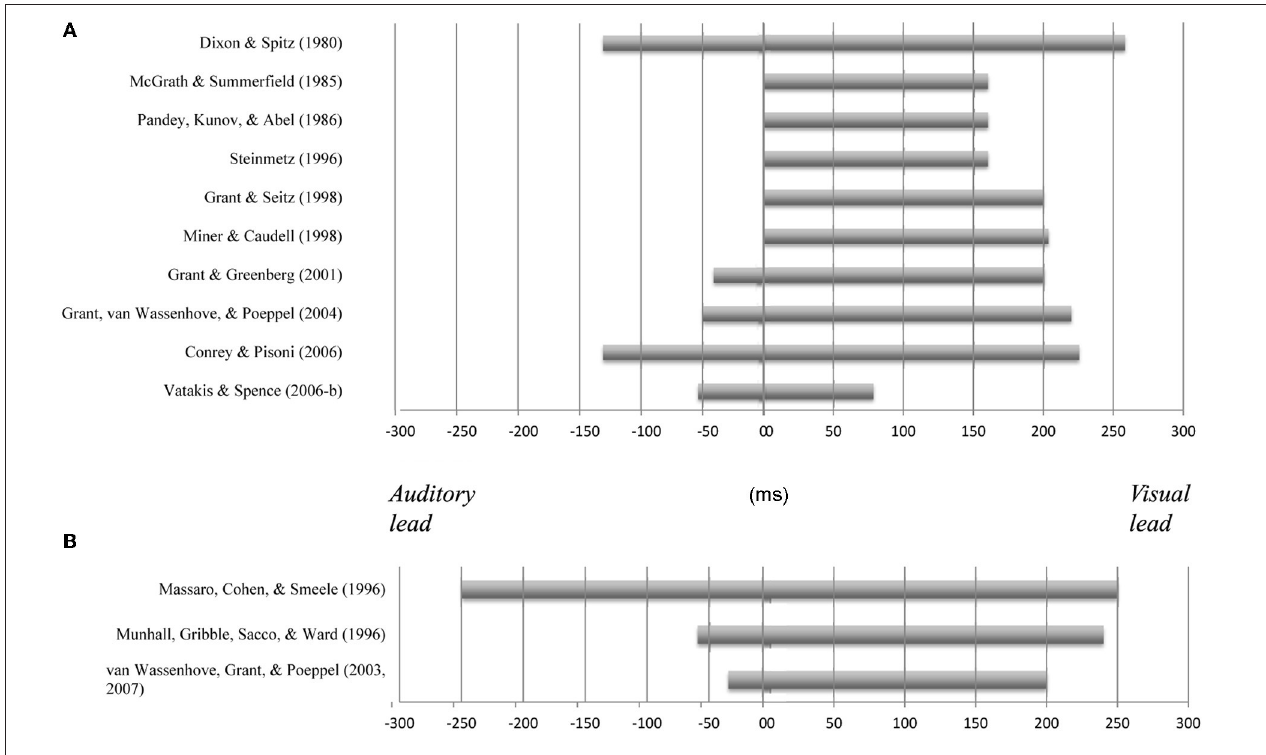
FIGURE 1 | Variability in the temporal window of multisensory integration observed in previous studies using continuous audiovisual speech stimuli and a variety of different response measures (including identification tasks, simultaneity judgment task, etc.; (A) and brief speech tokens in McGurk-type presentations